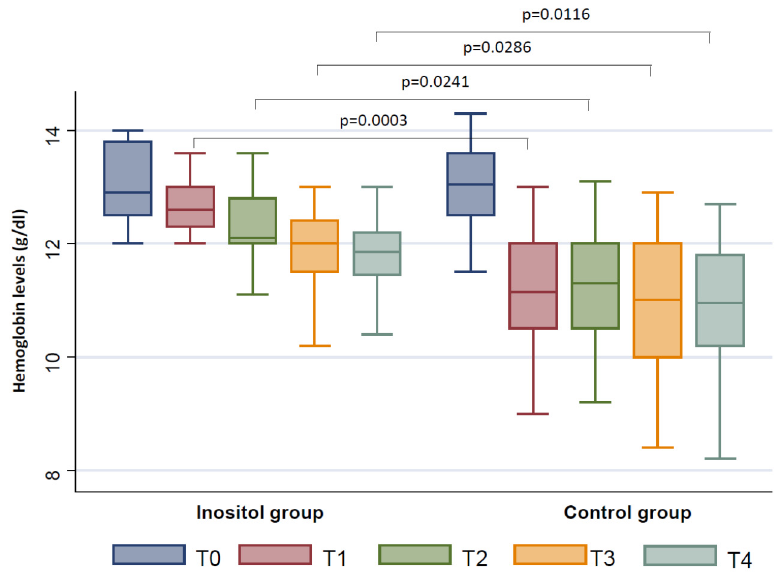
Figure 1. Changes from baseline in hemoglobin levels between the Inositol Group and the Control Group during the follow-up (T1–T4).